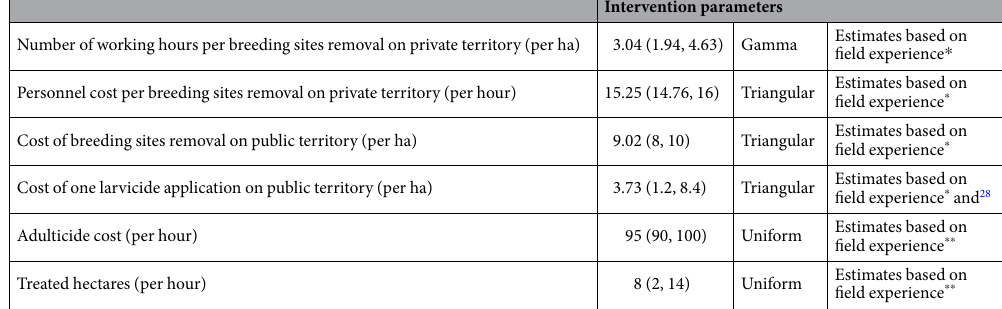
Table 2. Base case values and sampling distributions of the costs of interventions. * Vector control activities performed during 2015 in the province of Trento and Belluno by the personnel of the Istituto Zooprofilattico Sperimentale delle Venezie and the Fondazione Edmund Mach (see Appendix S1 for detailed information). ** Vector control activities performed during 2015 in the province of Belluno by the personnel of